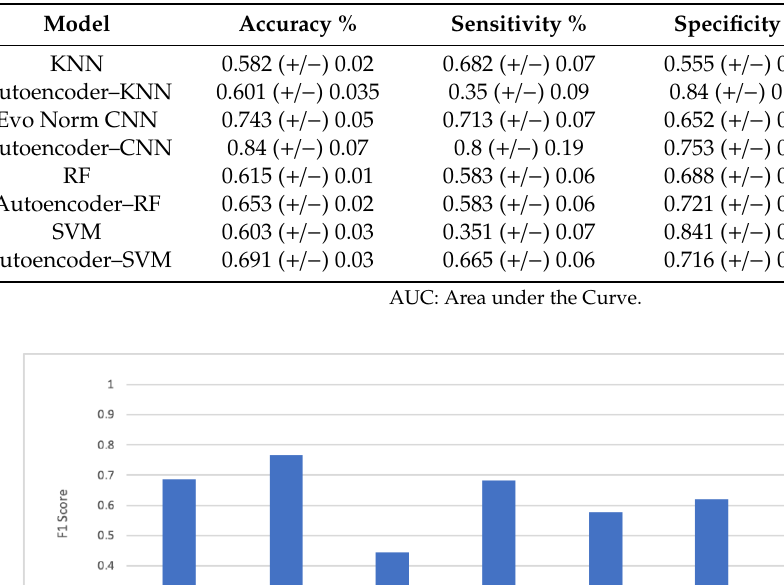
Figure 18. The F1 score.